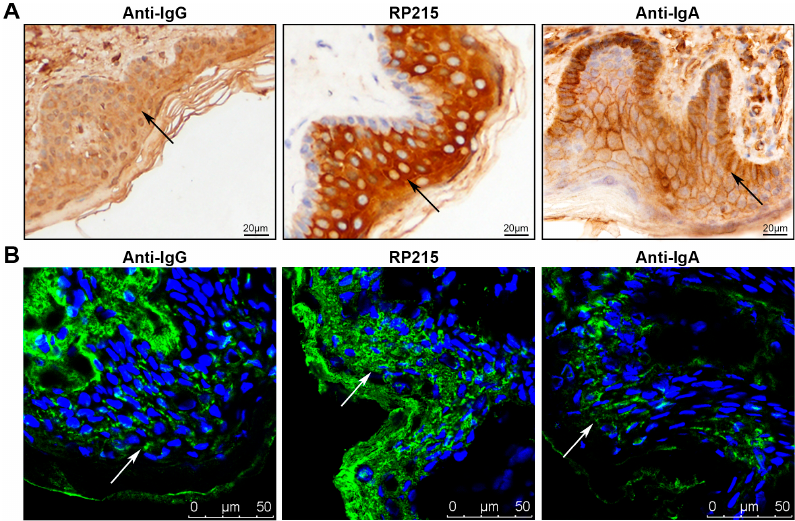
Figure 1. Immunoglobulin G (IgG) and immunoglobulin A (IgA) distribution in normal skin epidermis detected by immunostaining. ( A ) Immunohistochemical staining with commercial anti-IgG antibody, RP215 and anti-IgA antibody of paraffin-embedded sections of normal skin tissues. Arrows denote immunoreactivity of Ig; ( B ) Immunofluorescence staining with commercial anti-IgG antibody, RP215 and anti-IgA antibody in frozen sections of normal skin tissues. Green: immunostaining of Ig, blue: nucleus staining by Hochest 33342. Arrows denote immunoreactivity of